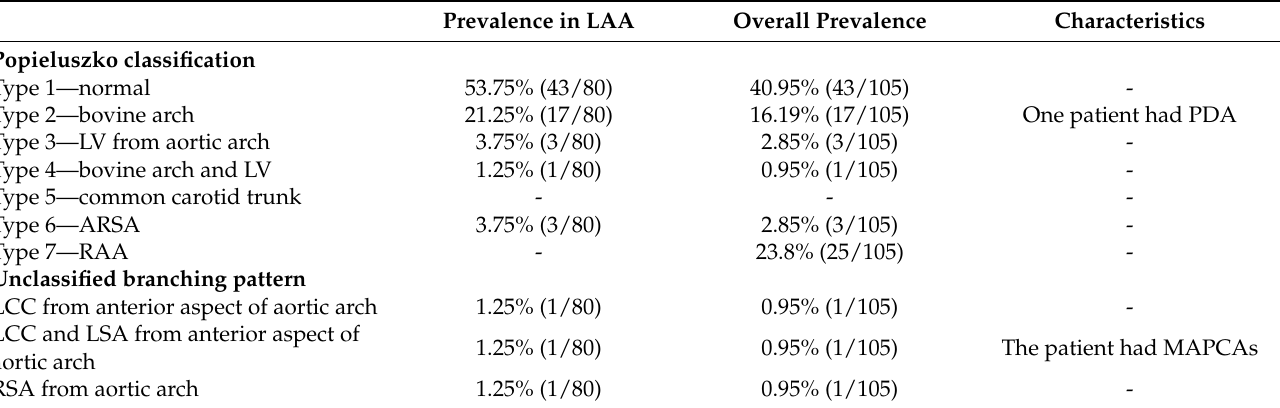
Table 3. Different types of aortic arch variations.